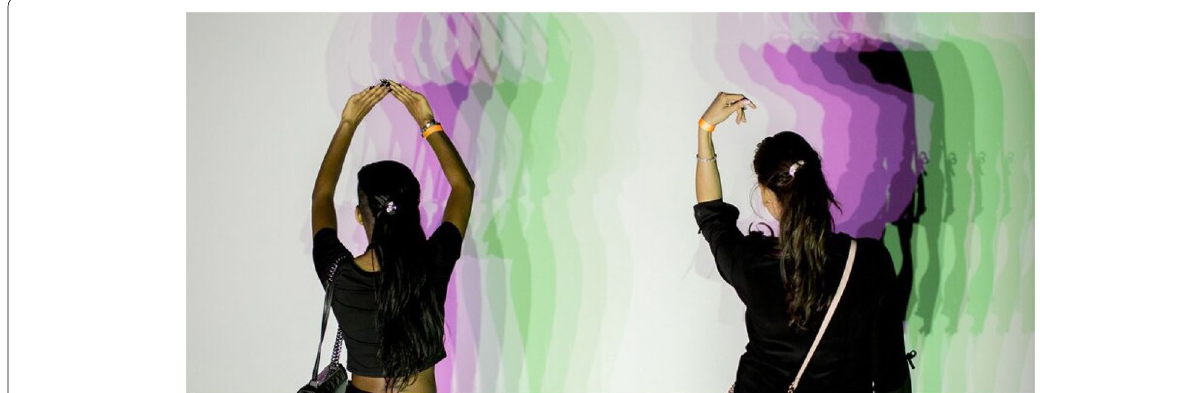
Fig. 34 A multiple shadow artwork created by Olafur Eliasson. He used multiple light sources to display the complex visual effects of human shadows